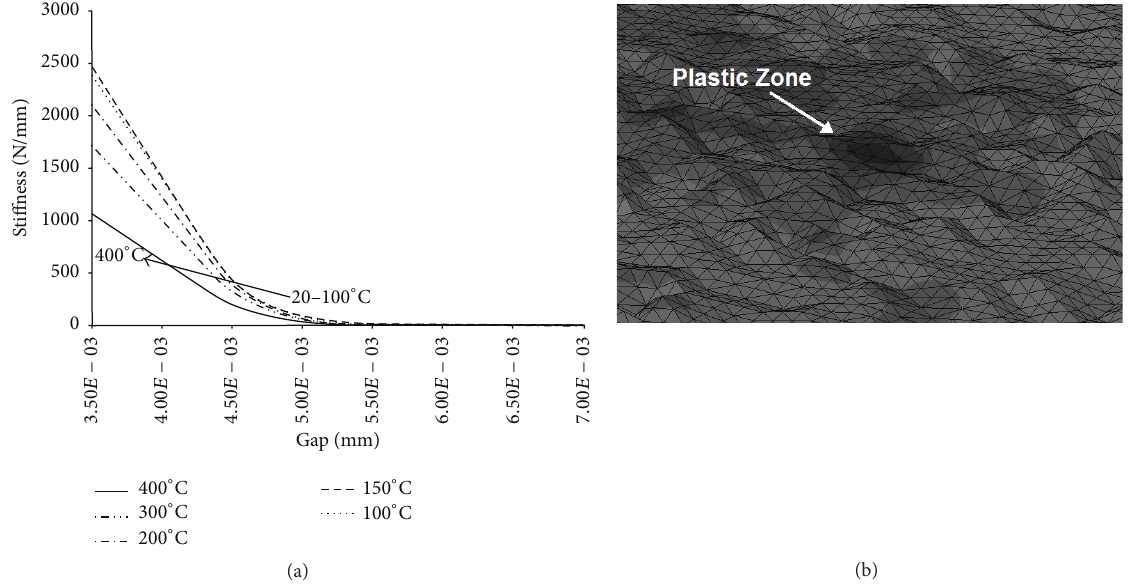
is evaluated following the relationship shown in Figure